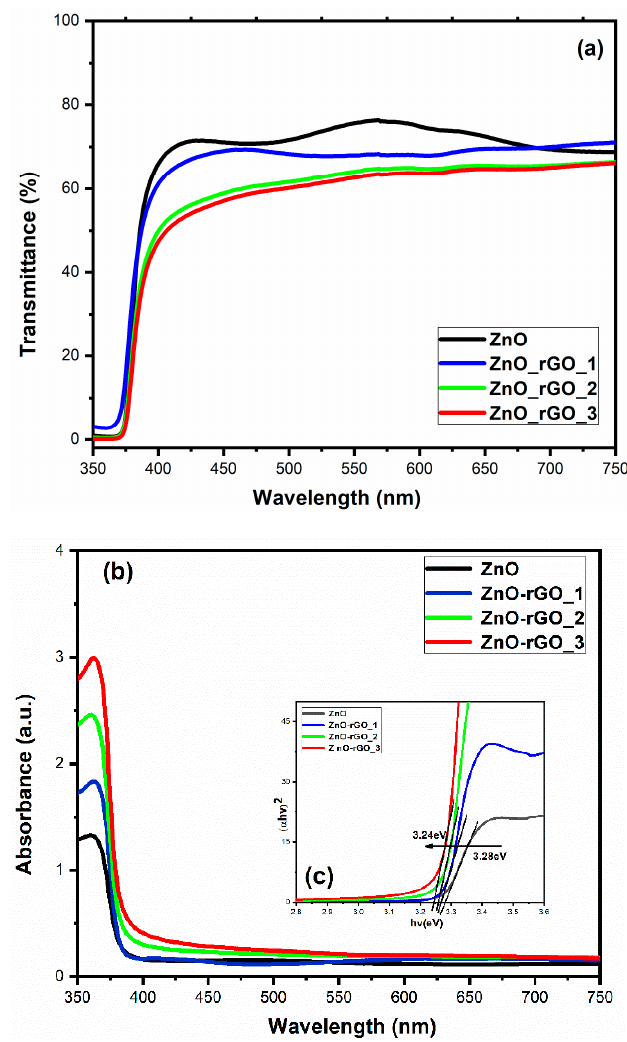
Figure 12. Optics measurement of ZnO and ZnO-rGO thin films, ( a ) transmittance spectra, ( b ) absorbance spectra and ( c ) the inset confirmed the band gap estimation.